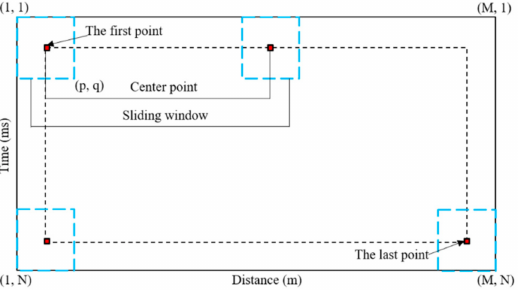
Figure 1. Parameter estimation strategy of a non-stationary random medium.